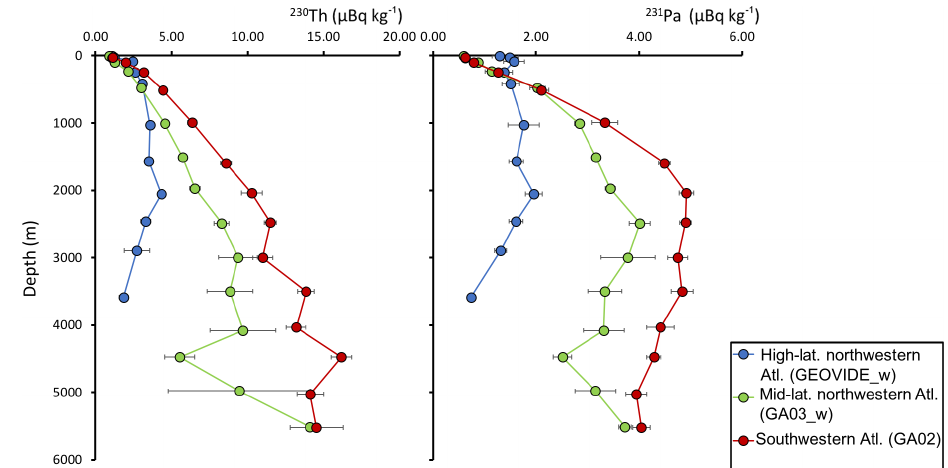
Figure 3. Vertical profiles of 230 Th and 231 Pa from high-latitude northwestern Atlantic (west section of GEOVIDE), mid-latitude northwest- ern Atlantic (GA03_w), and southwestern Atlantic (GA02). Data from all stations were sorted by water depth, and averages for depth and 230 Th and 231 Pa concentrations were taken for surface, 25, 100, 250, and 500m, and every 500m interval below. Error bars on 230 Th and 231 Pa concentration averages reflect standard deviation of the mean of